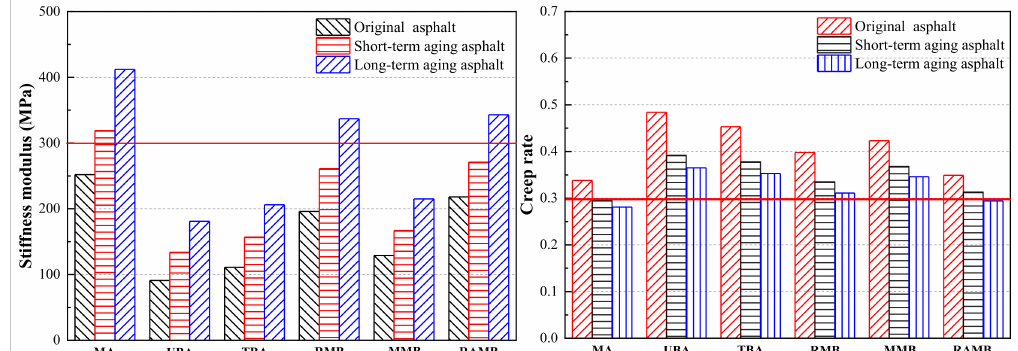
Figure 12. CMAI and PAAI of long-term aging of six asphalts.